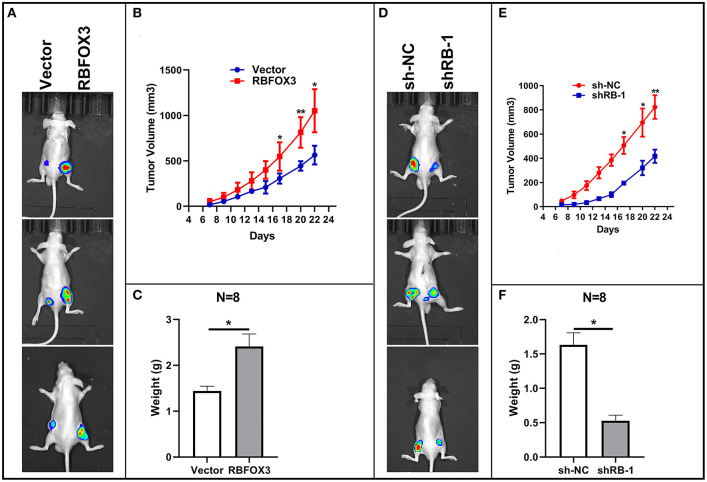
Dysregulation of RBFOX3-suppressed cell multiplication in gastric cancer (GC) orthotopic xenografts. Stable transfection of the SGC-7901 and MGC-803 cells with pcDNA3.1-RBFOX3 plasmid or empty plasmid (Vector) and RBFOX3 shRNA or negative control vector (sh-NC), respectively. Next, we subcutaneously injected the transfected GC cells into nude mice, and xenograft tumor growth was determined for 25 days. (A–C) IVIS representative images showing the tumor size (A), growth curves of tumor volumes (B), and tumor weight (C) in RBFOX3 overexpressed arm vs. control arm. (D–F) IVIS representative images showing the tumor size (D), growth curves of tumor volumes (E), and tumor weight (F) in shRB-1 arm vs. controls. n = 8, *p < 0.05, **p < 0.01.